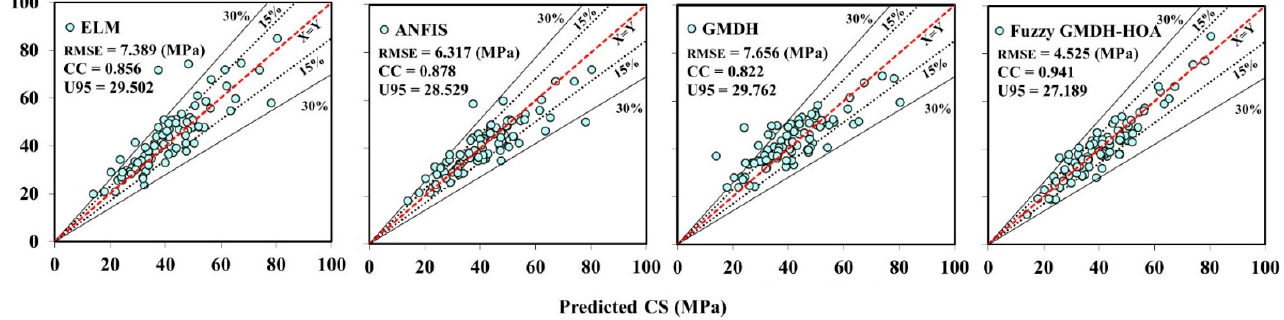
Figure 7. Testing performances of proposed models for CS of RCDWAC.